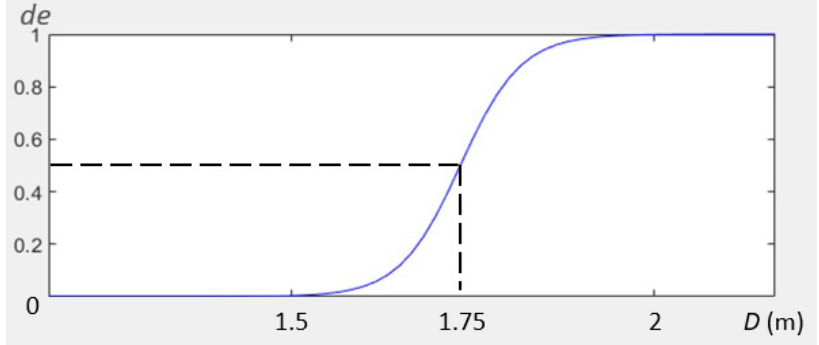
Figure 5. Safety zones around the robot.